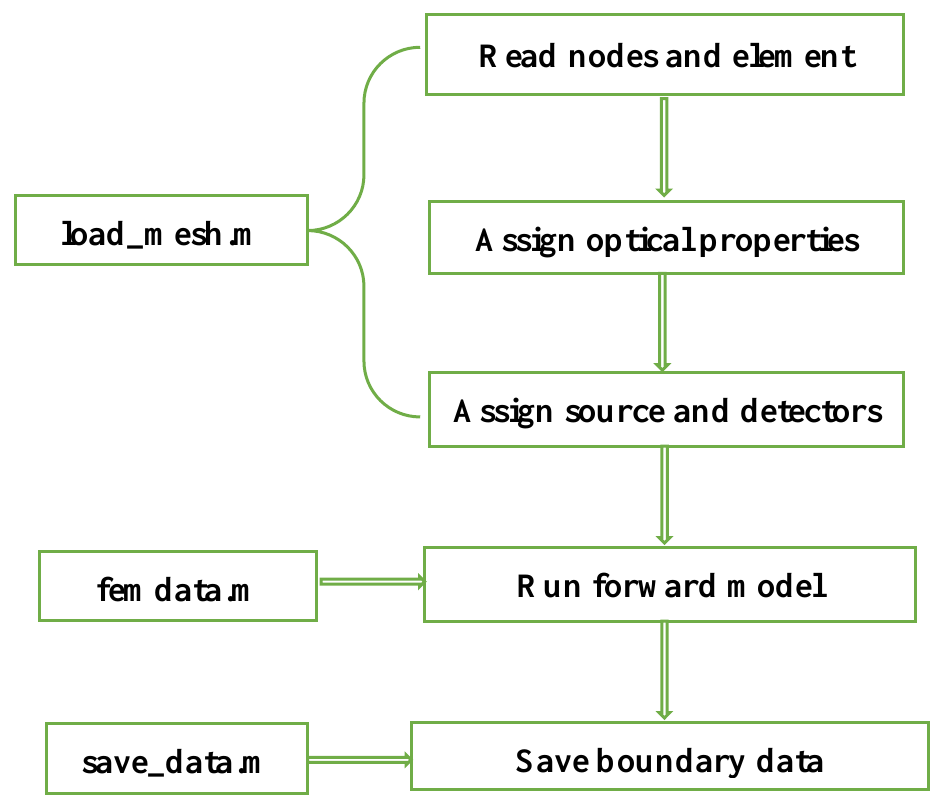
Figure 4. Fundamental steps of the NIRFAST technique for the forward problem (adapted from Ref. [54]).